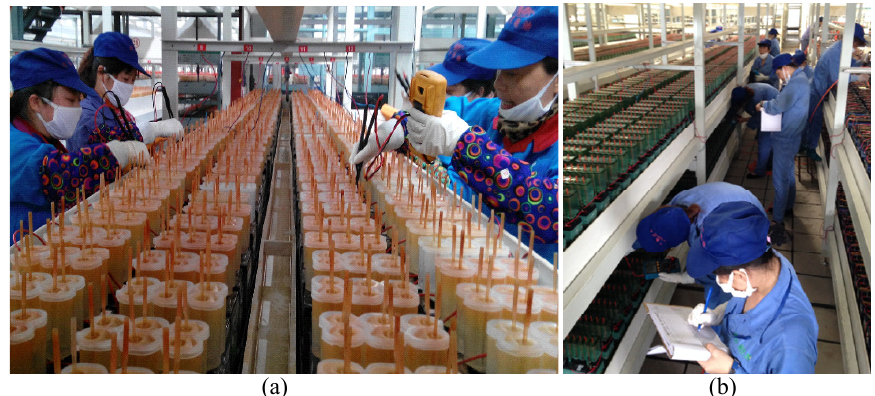
Figure 1. A practical battery production process: ( a ) Manual measurement of battery voltages; ( b ) Manual battery